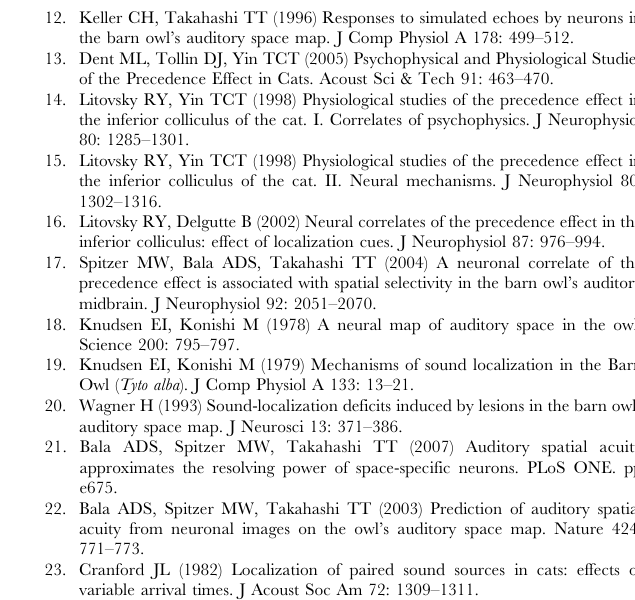
Figure S2 Saccade latency (A) and localization error (B) measured separately for each bird (C, S, and T). Plotted are the median values for lead-directed (filled symbols) and lag-directed saccades (open symbols) and for saccades directed towards single sound sources (black line). For paired stimuli (colored lines),